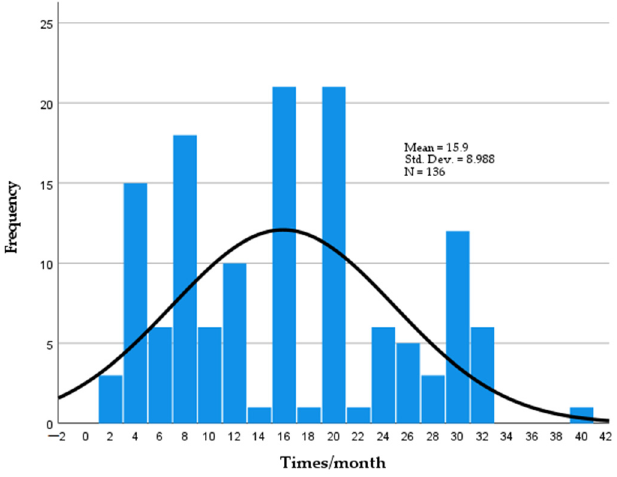
Figure 2. Pork consumption per